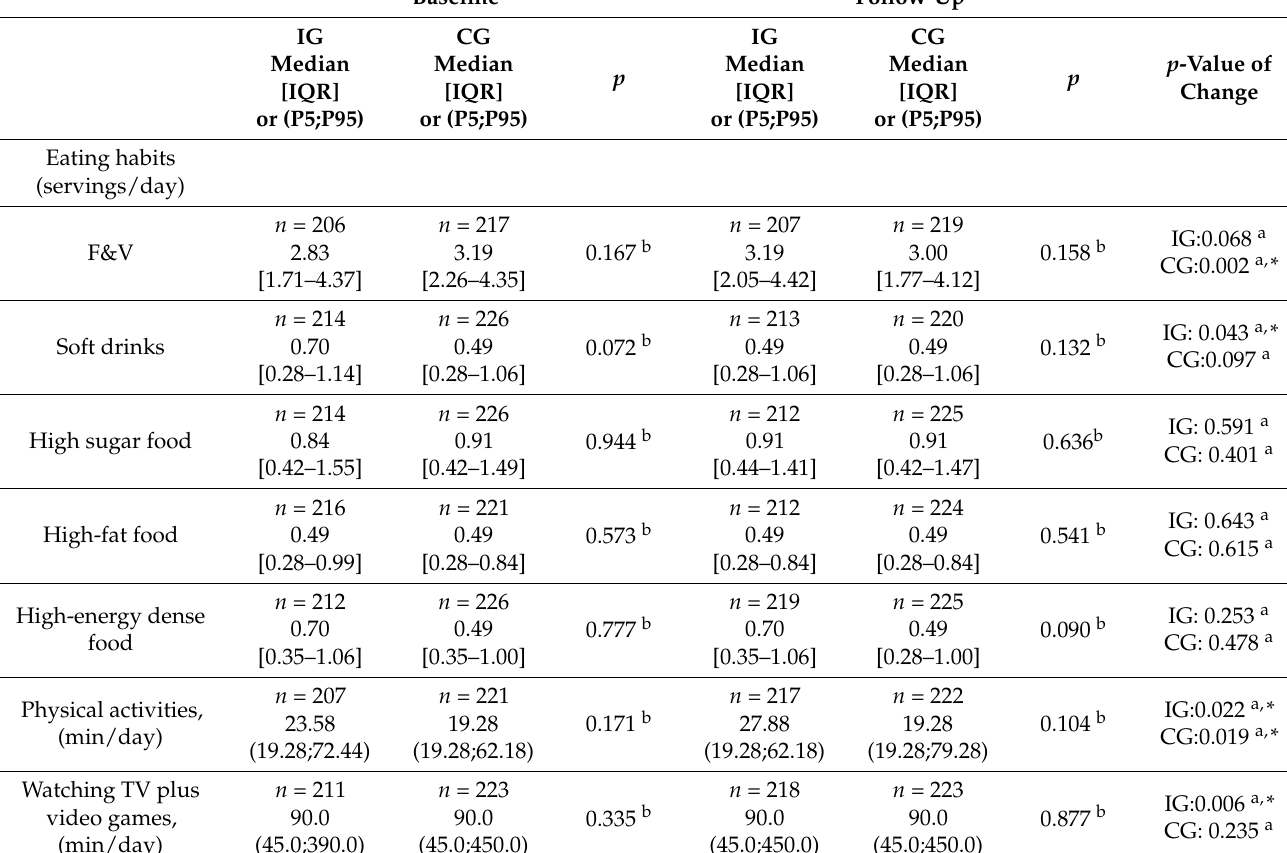
Table 4. Changes on eating, physical activity, and sedentary habits for intervention ( n = 219) and control group ( n = 230).